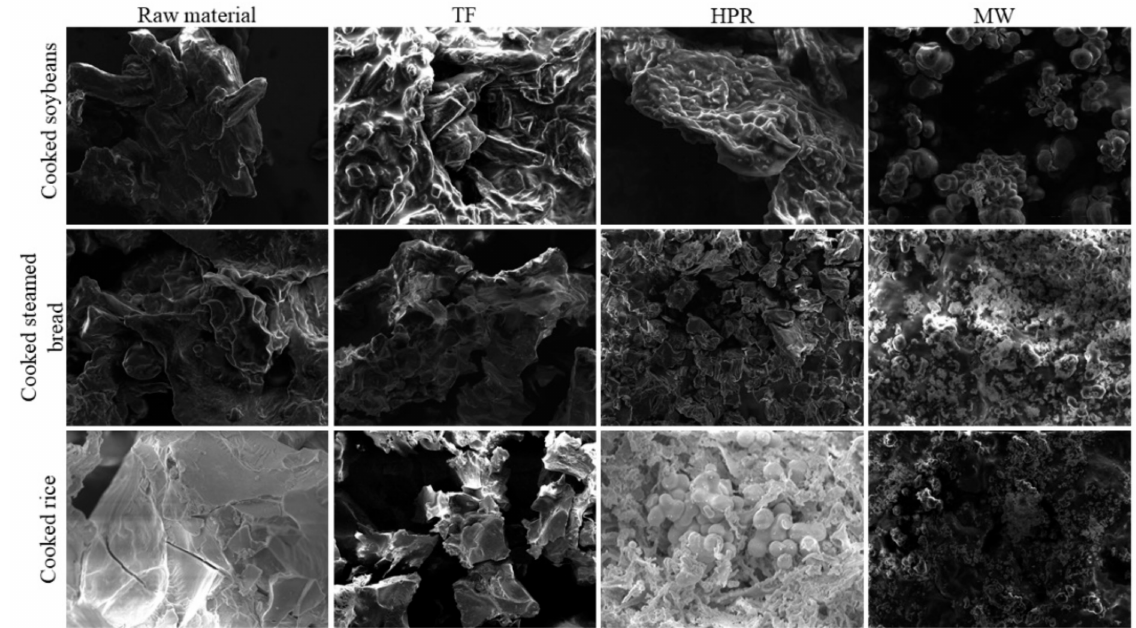
Figure 14. SEM image of biochar obtained with different treatments and its raw materials (1500 ×